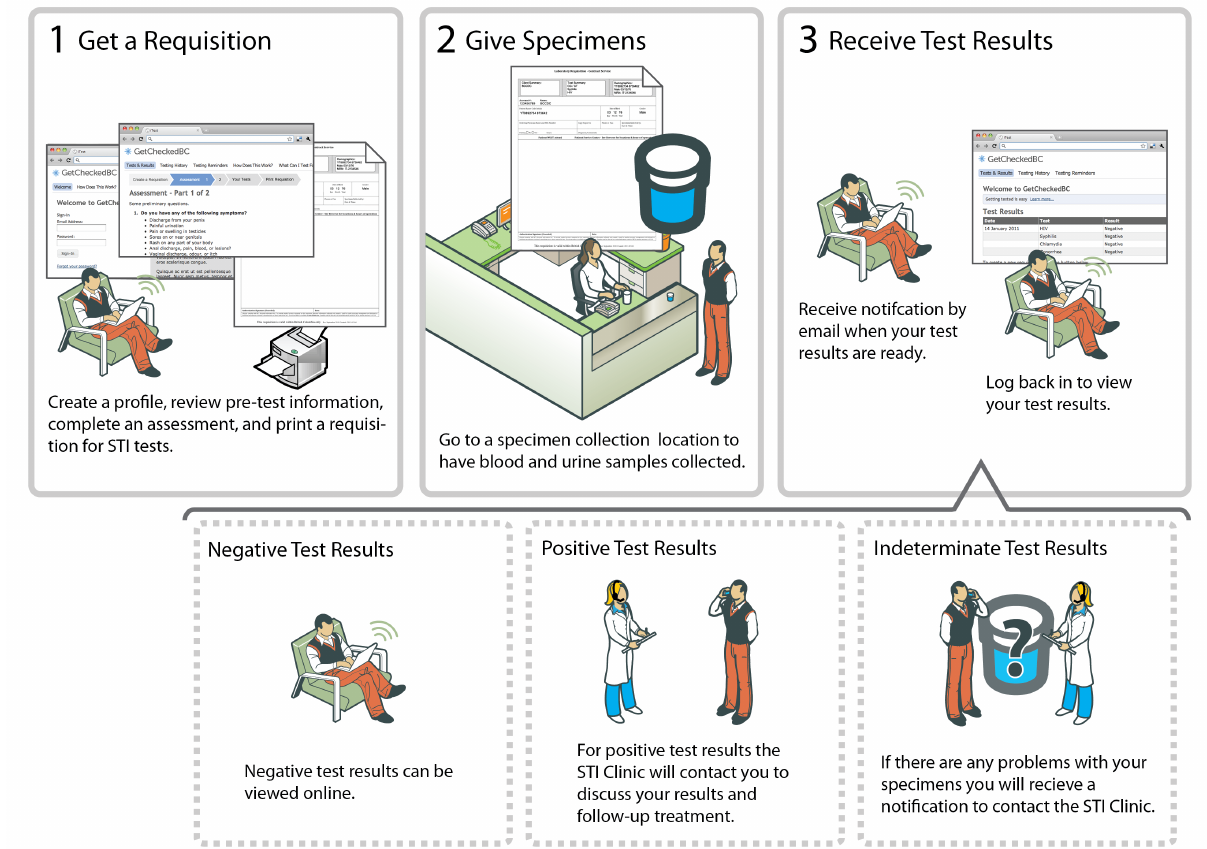
Figure 1. Proposed British Columbia Internet-based sexually transmitted infection (STI)/human immunodeficiency virus testing model, as presented to focus group